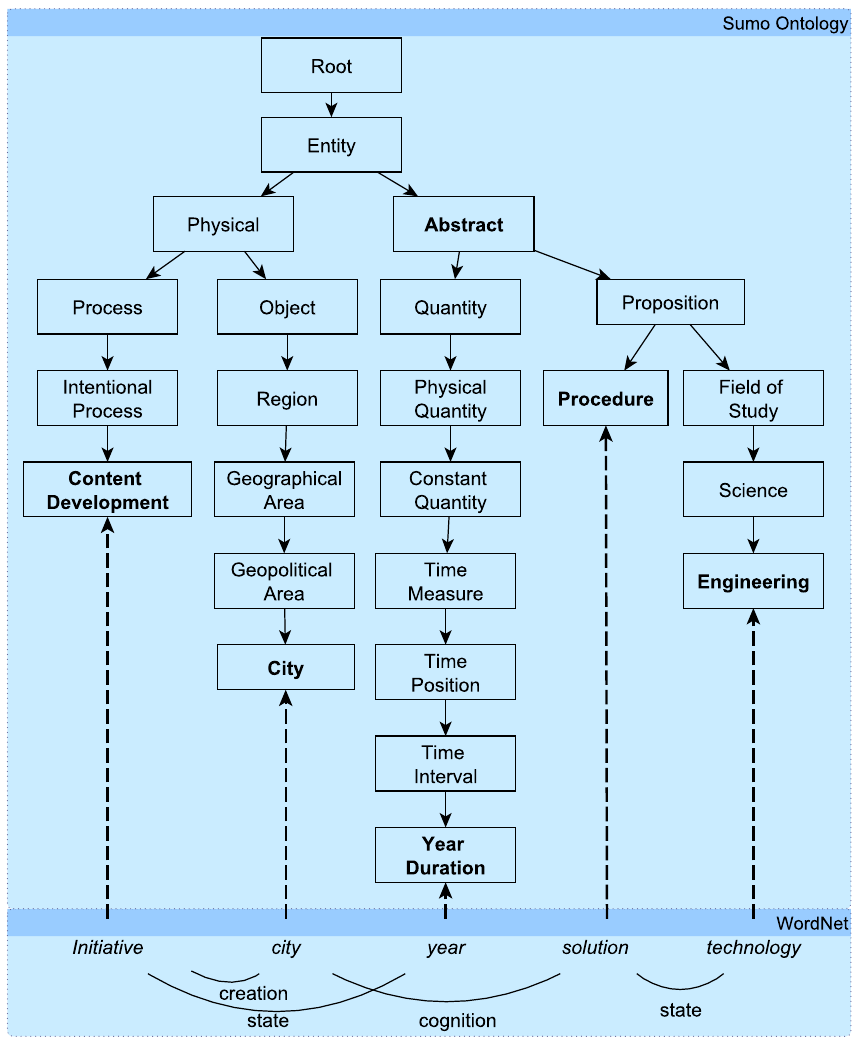
Figure 4. Example mapping of the semantic network generated for the sentence shown in Section 3.2.1 into the hierarchical structure of the SUMO ontology. Each noun in the sentence can be abstracted by navigating the structure of the SUMO